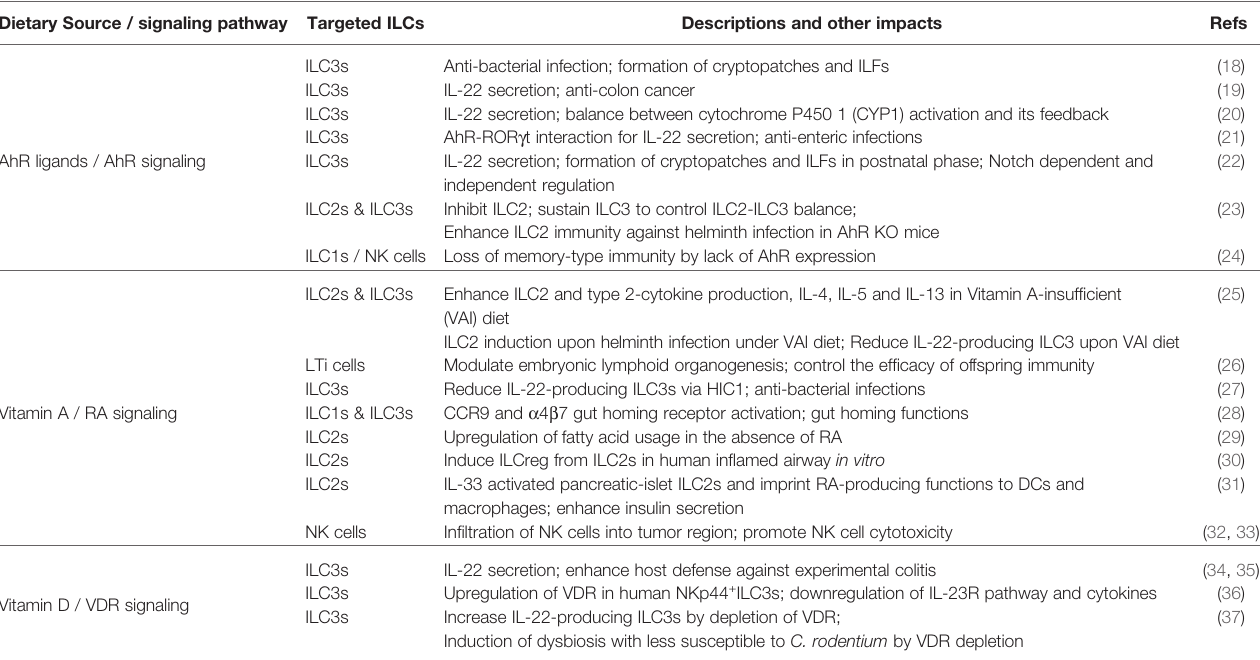
TABLE 1 | Micronutrients and associated signaling pathways that affect innate lymphoid cells (ILCs). Dietary Source / signaling pathway Targeted